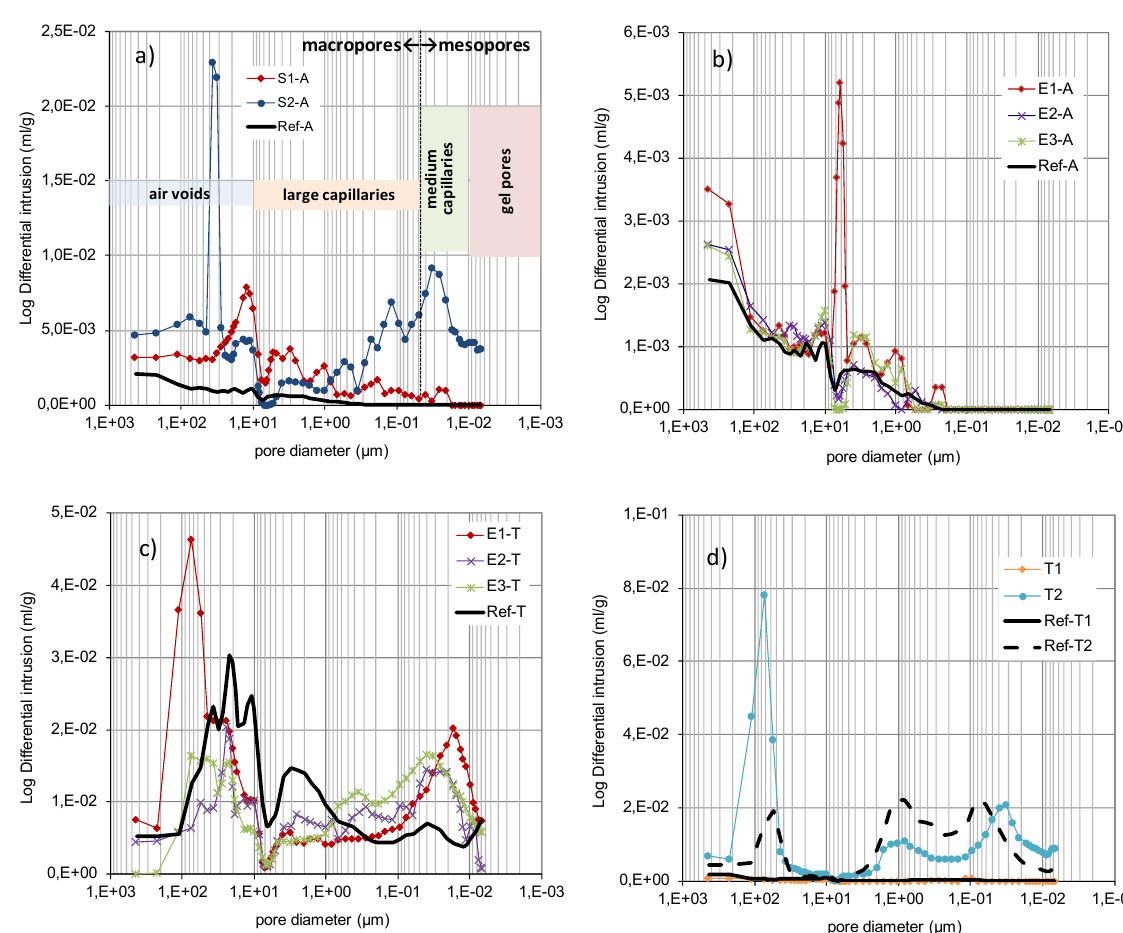
Figure 3. ( a – d ) Differential pore size distribution in the Figure 3. ( a – d ). Differential pore size distribution in the samples.